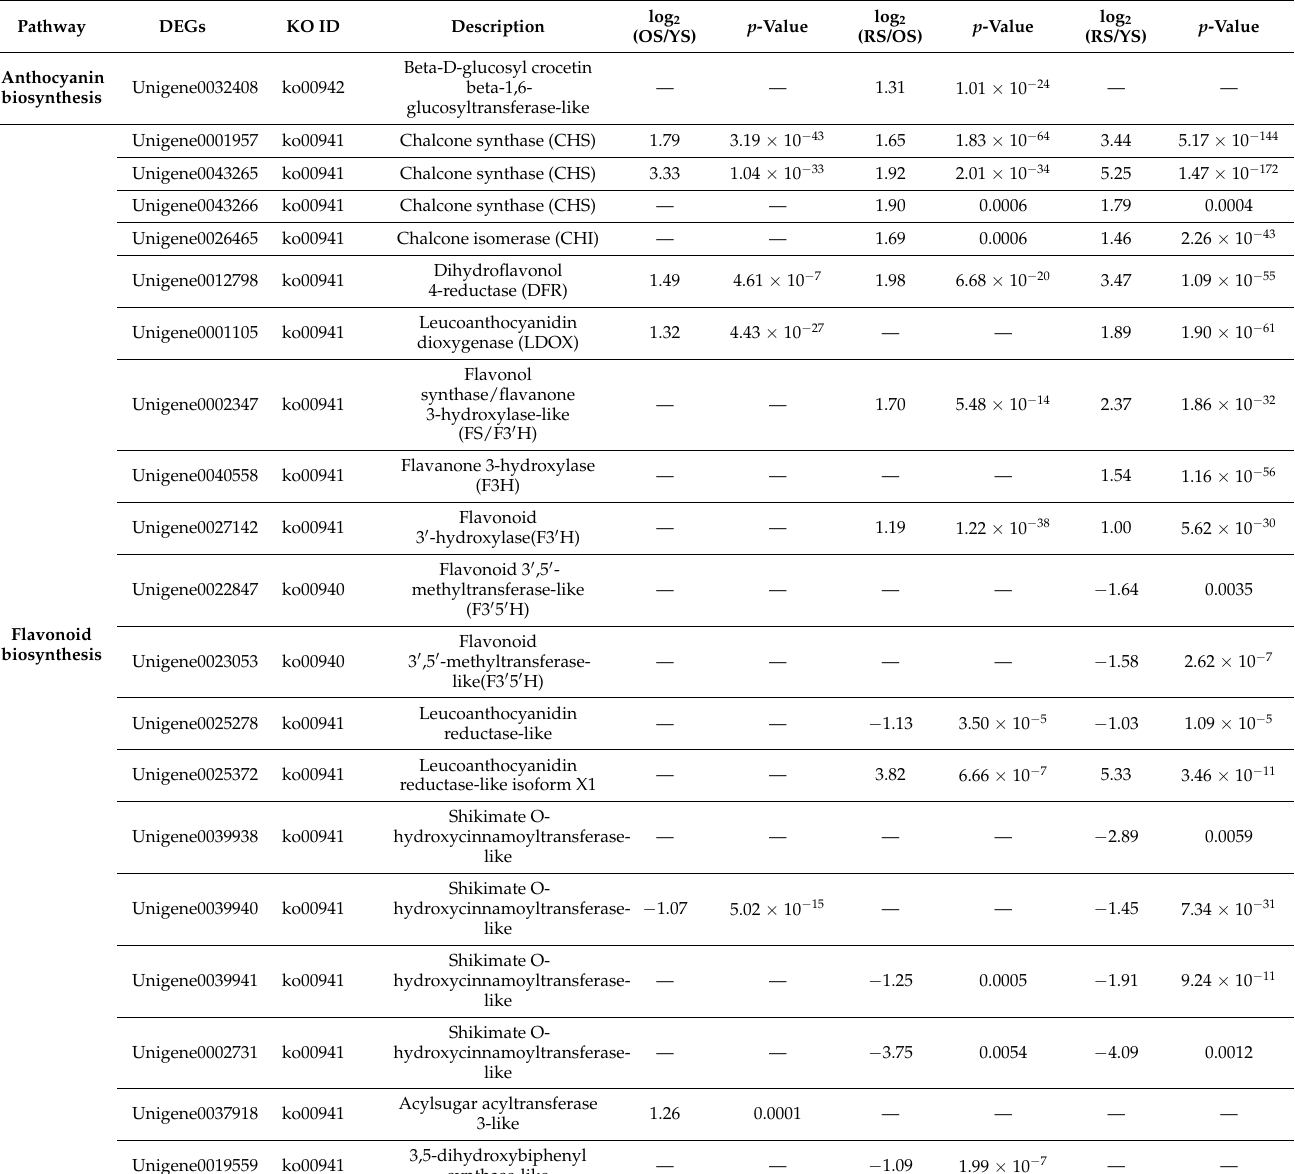
Table 2. Pathways associated with candidate differentially expressed genes involved in anthocyanin biosynthesis and flavonoid biosynthesis in ‘Huaxiu’